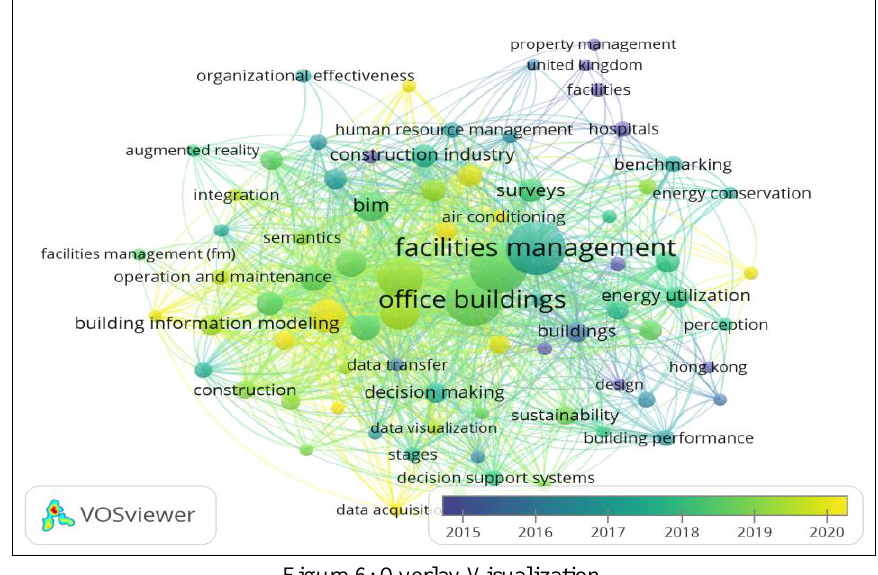
Figure 6: Overlay